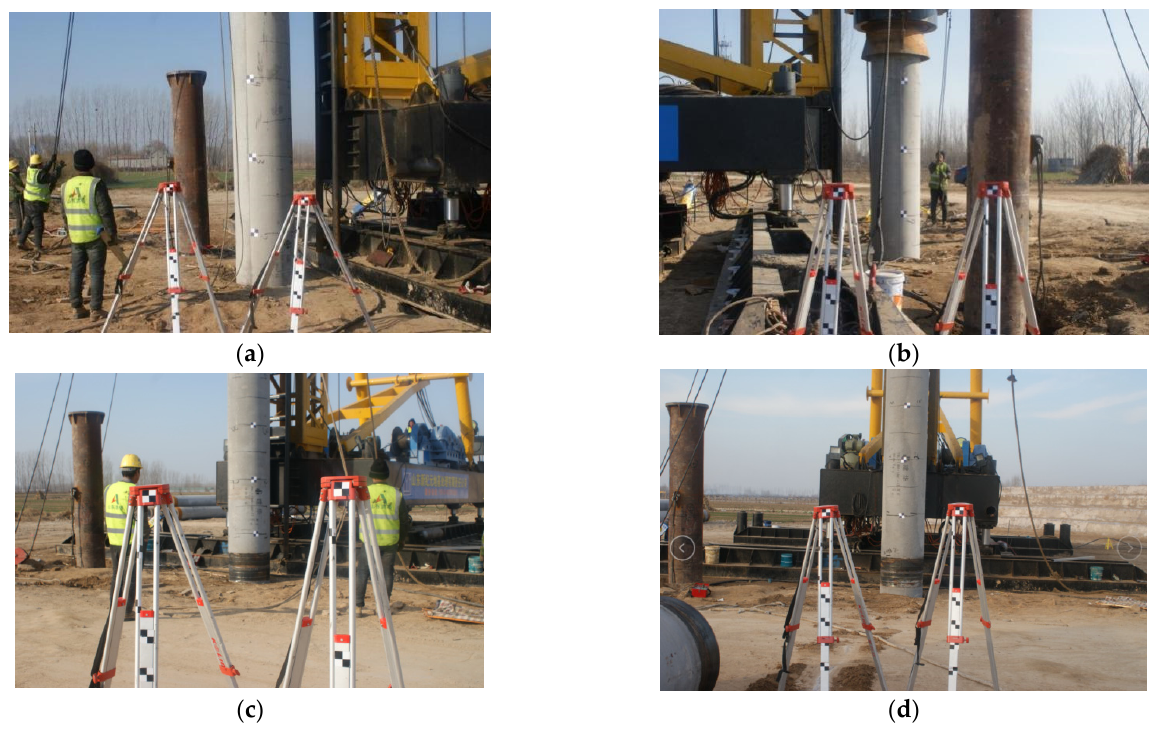
Figure 6. Large diameter Pipe Pile Penetration Monitoring Experiment Site, displaying the ( a ) test of the first pipe pile at No. 6 pile site, ( b ) test of the second pipe pile at No. 6 pile site, ( c ) test of the third pipe pile at No. 6 pile site, and ( d ) test of the fourth pipe pile at No. 6 pile site.